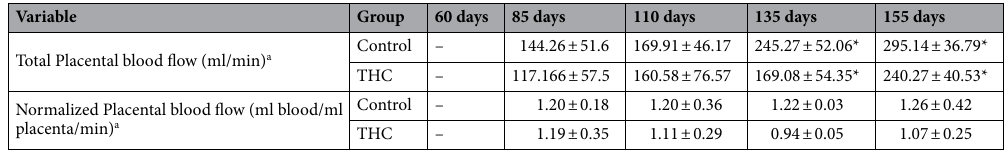
Table 3. Dynamic contrast-enhanced MRI measurements. *p < 0.05. a Obtained by DCE-MRI.